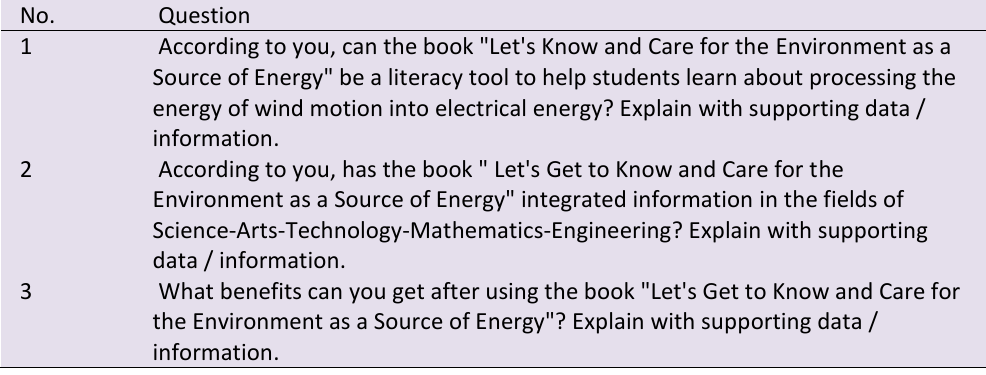
Table 5 . Questionnaire of Pictorial Story Usefullness